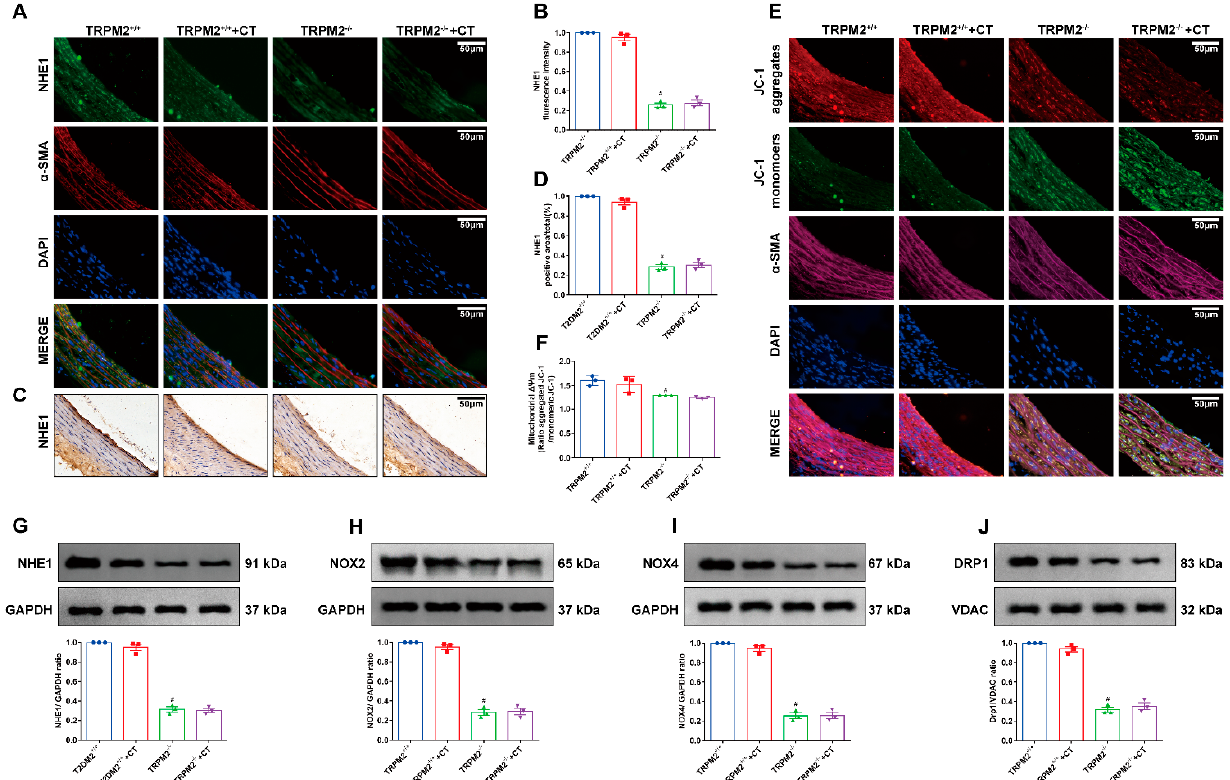
Figure 6. CT had no effect on the expression of NHE1 protein in TRPM2 knockout mice. ( A ) The immunofluorescence detection of NHE1 in carotid arteries (NHE1, green ; α -SMA, red ). ( B ) Quantitative analysis of fluorescence intensity of NHE1. ( C ) The immunohistochemistry detection of NHE1 in carotid arteries. ( D ) Quantitative analysis of positive intensity of NHE1. ( E ) Detection of mitochondrial membrane potential in carotid arteries (JC-1aggregates, red; JC-1 monomers, green; α -SMA, purple). ( F ) The quantitative analysis of the mitochondrial membrane potential ( Δψ m). ( G – J ) Western blot analysis of NHE1, NOX2, NOX4, and DRP1 in carotid arteries (N = 3). Data were analyzed by one-way ANOVA by Tukey post hoc tests or Bonferroni post hoc analyses. All data were expressed as mean ± SEM. # p < 0.05 vs. TRPM2 +/+ group.